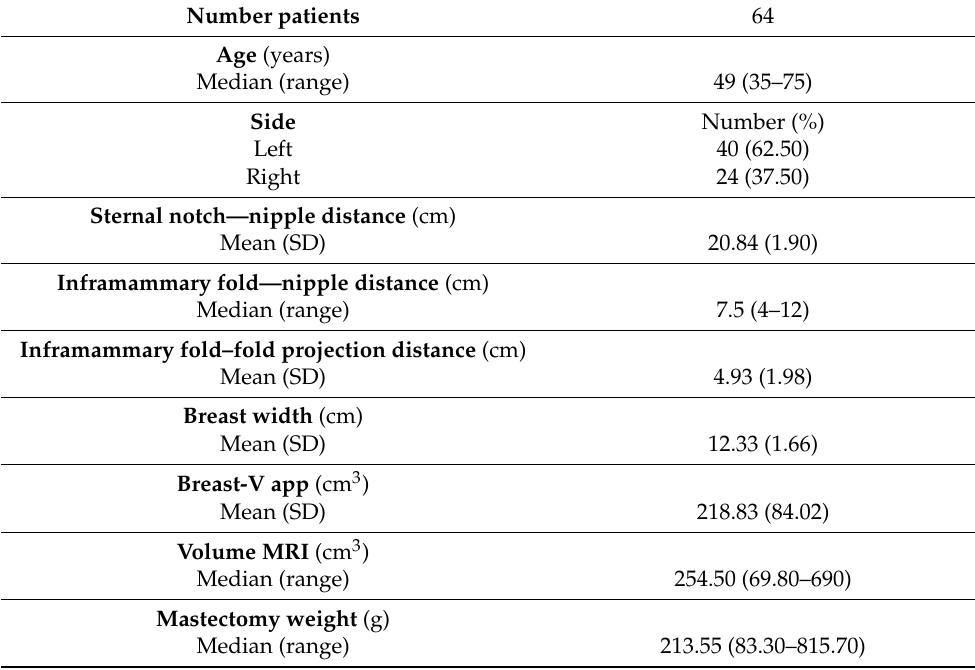
Table 1. Patient